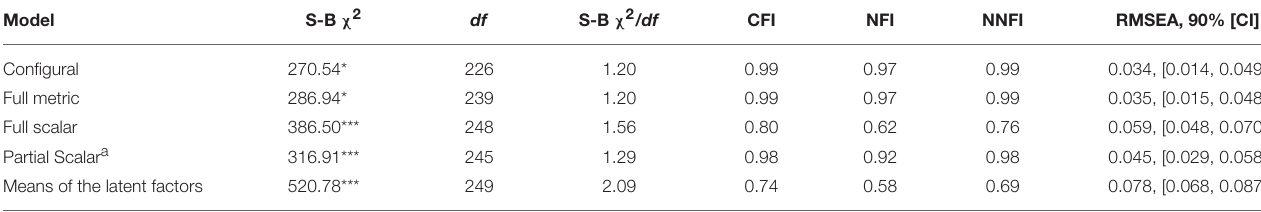
TABLE 7 | Model summary for multi-group test of measurement invariance.